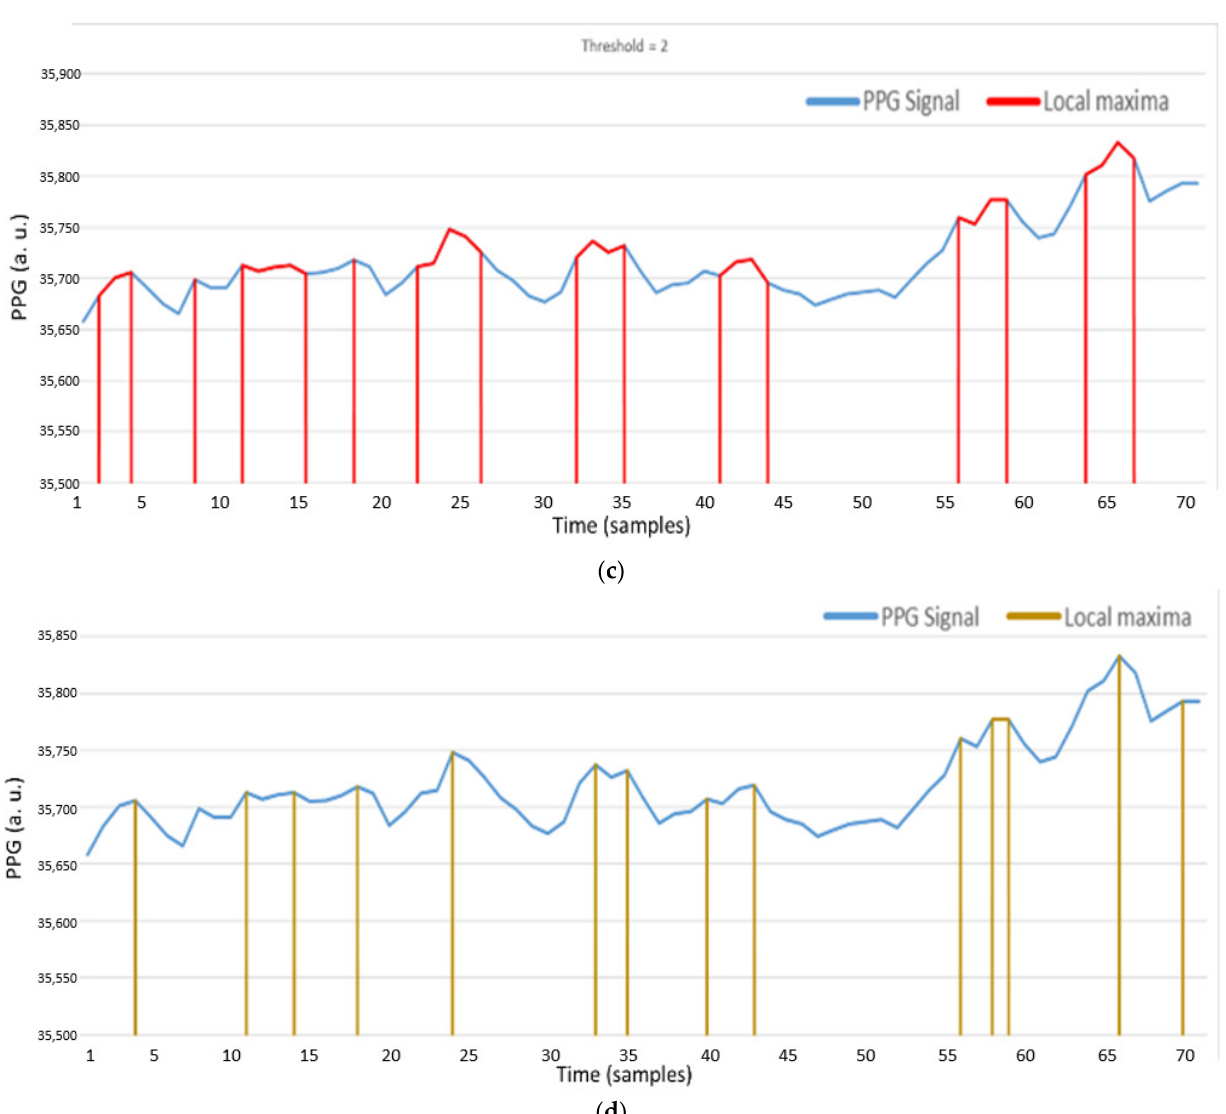
Figure 20. ( a ) PPG signal on the wrist; ( b ) Local maxima of a PPG signal with AMPD-BL algorithm (AMPD Threshold = 6/ L , L = 7); ( c ) Local maxima of a PPG signal with AMPD-BL algorithm (AMPD Threshold = 2/ L , L = 7); ( d ) Local maxima of a PPG signal with AMPD-Fuzzy ( L = 1).